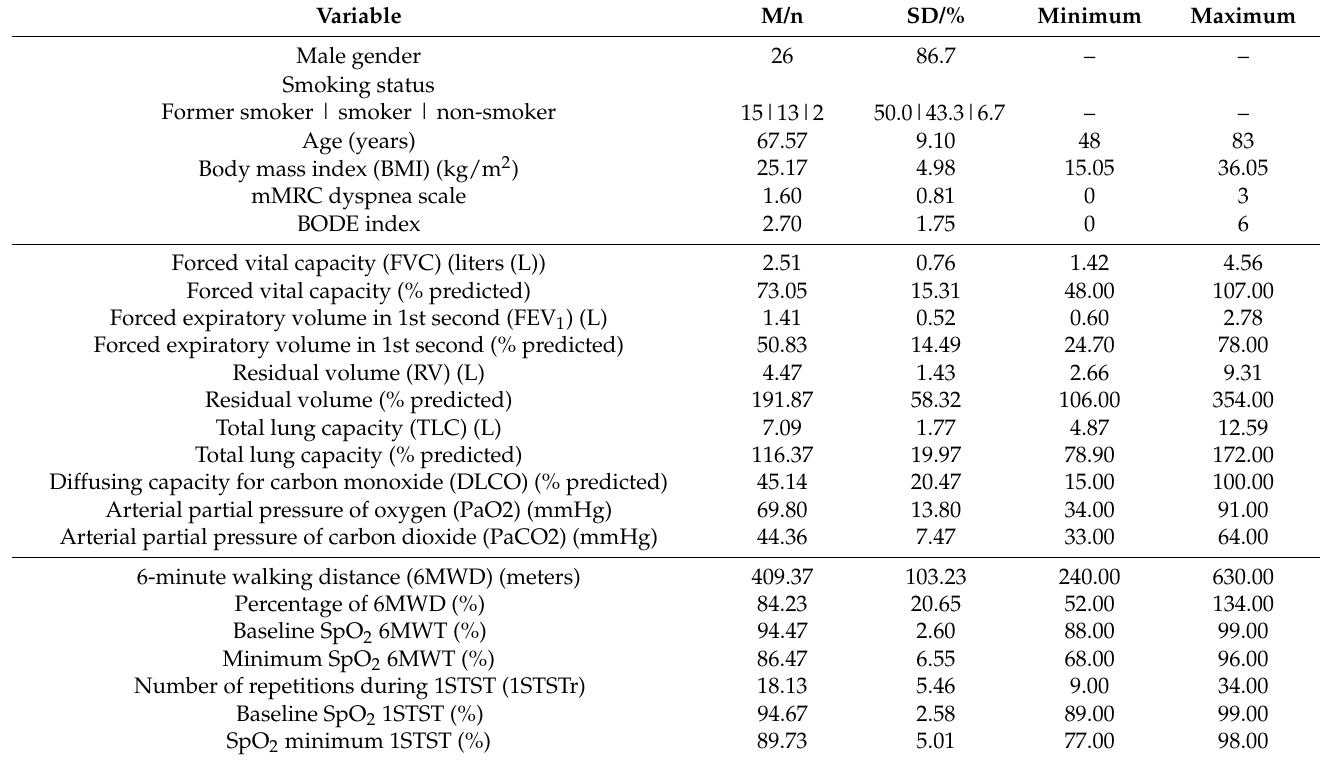
Table 1. Patients’ baseline characteristics, lung function tests, and results of the 1STST and the 6MWT. (M = mean; SD = standard deviation; 1STST = 1-min sit-to-stand test; 6MWT = 6-min walking test; mMRC = modified Medical Research Council; BODE = index with BMI, FEV 1 , 6MWD, and mMRC; L=